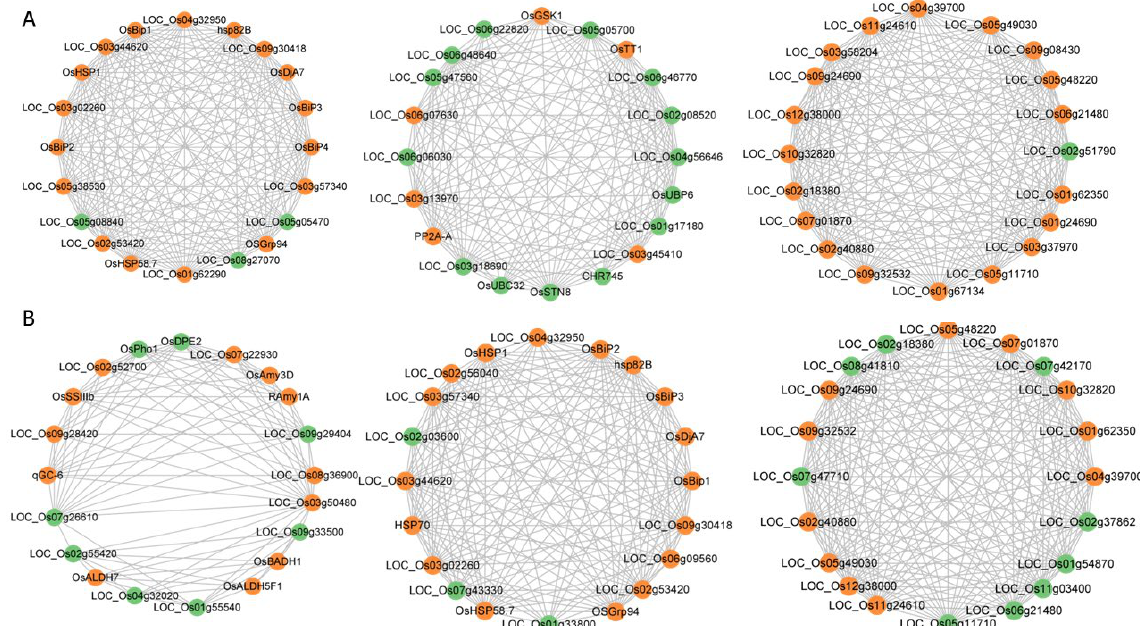
Figure 4. 60 candidate–hub genes of IR64 ( A ) and Koshihikari ( B ) obtained from the interaction network analysis with known–core genes. Yellow color represents the genes from known–core genes; green color represents the genes from DEGs in this study.